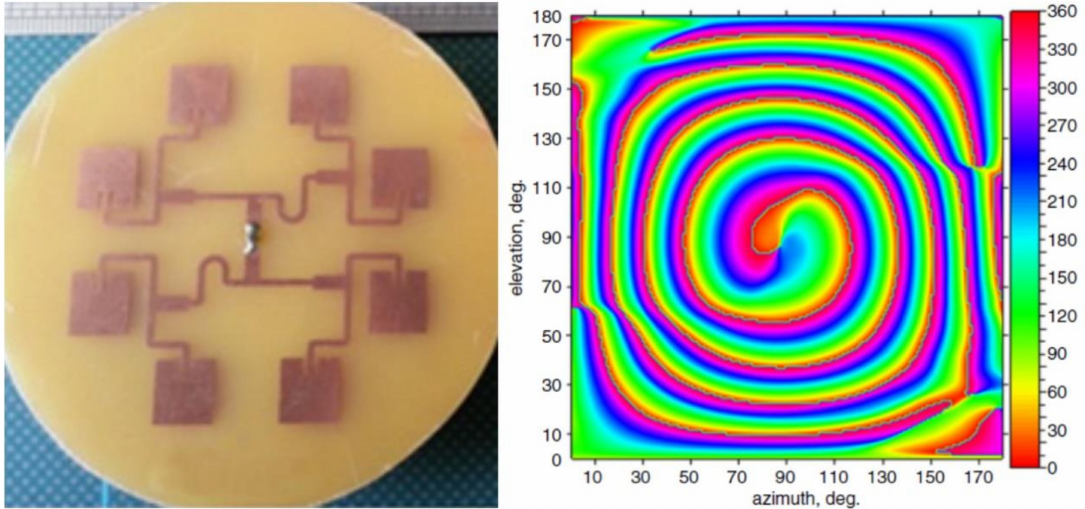
Figure 7. Photography of the first experimental prototype of a phased antenna array for OAM vortex wave generation and its measured phase pattern